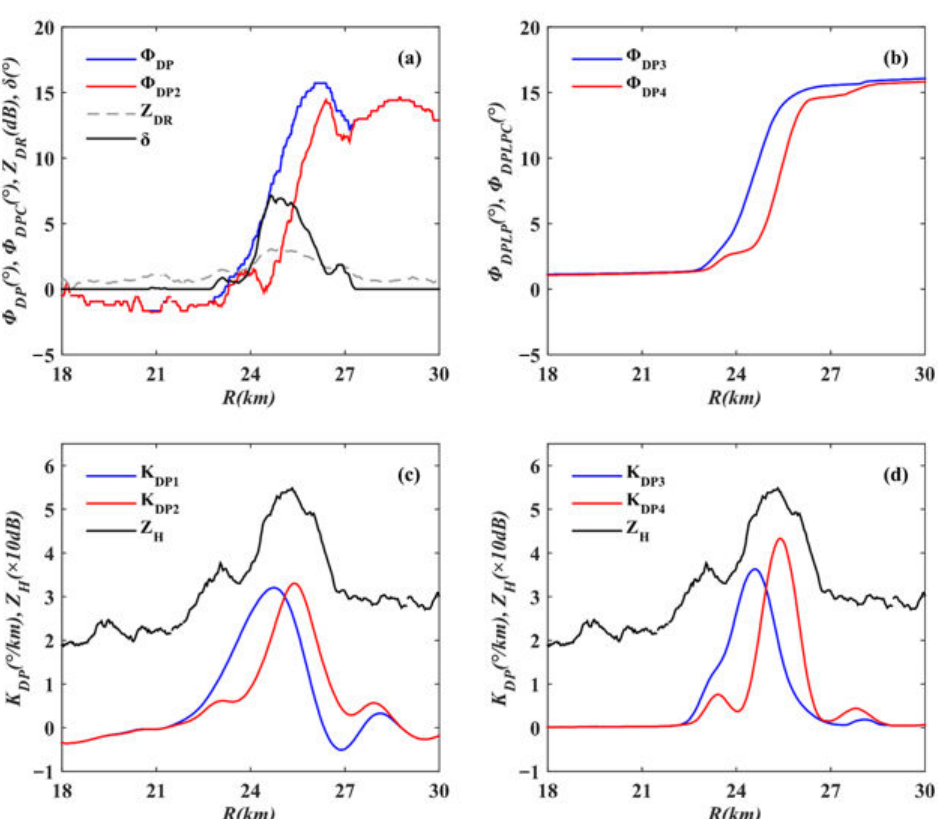
Figure 7. Typical radar sounding of ( a ) Φ DP , Z DR , and δ obtained by Z DR , and Φ DP2 obtained by δ correction; ( b ) LP-processed results obtained before (blue curve) and after (red curve) δ correction; ( c ) Z H after attenuation correction (dBZ) and K DP before and after δ correction using LS; and ( d ) Z H after attenuation correction (dBZ) and K DP before and after δ correction using